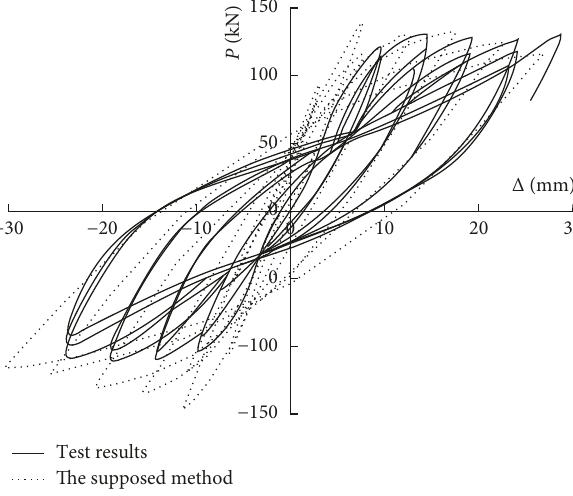
Figure 7: Hysteretic curves on top floor of the specimen.